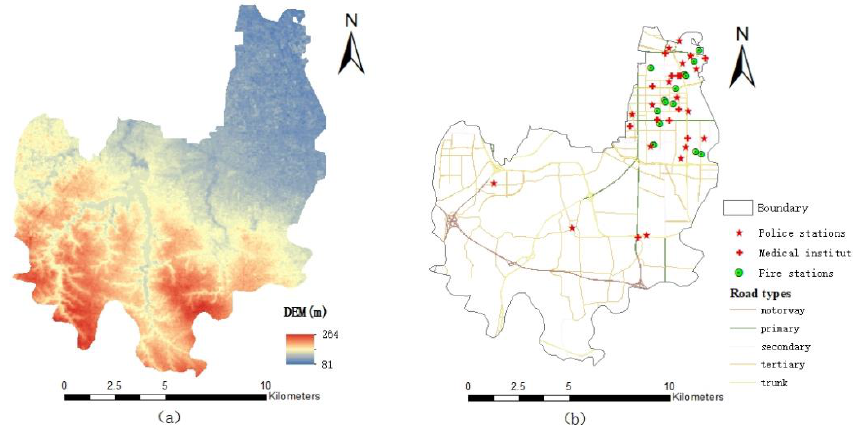
Figure 2. Schematic of study area: ( a ) Digital elevation model (DEM); ( b ) the location of Public Service Organization and Road types.